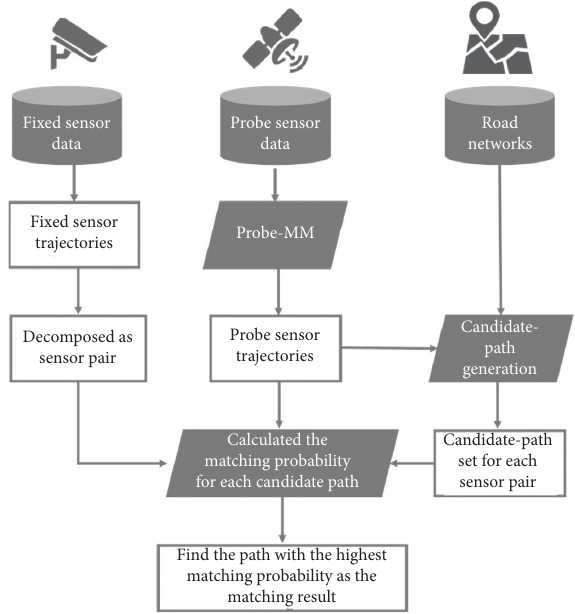
Figure 2: Framework of the proposed Fixed-MM